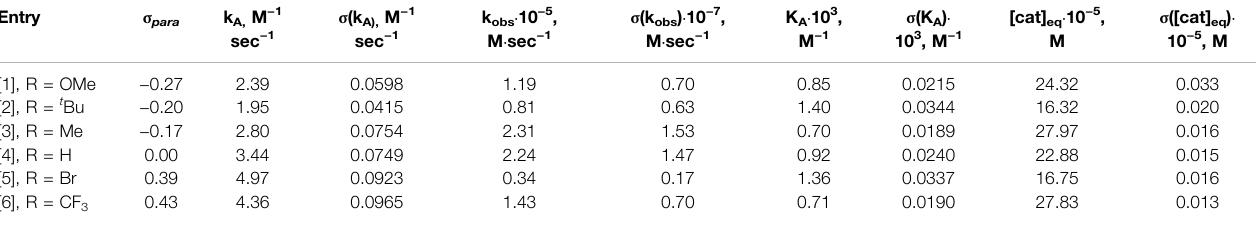
TABLE2| Rateparametersk A ,k − A ,K A ,[cat] eq. ,derivedfromthecyclicvoltammetrykineticstudiesat25 ° CindryDMSOat100 mV/secandk obs ,obtainedby 1 HkineticNMR at 60 ° C in dry DMSO-d6, with corresponding standard deviations.